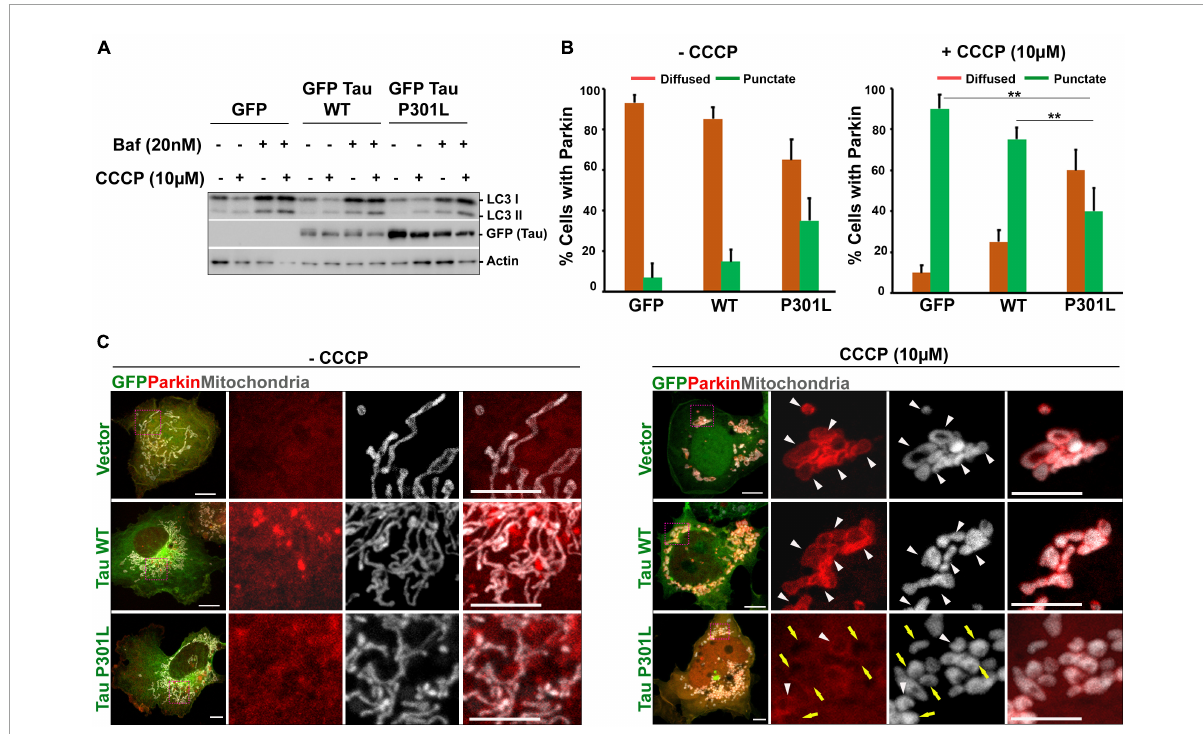
FIGURE2 P301L inhibits parkin translocation to mitochondria in COS7 Cells: (A) Representative immunoblot to show that autophagy flux is not altered in cells expressing either wild-type or P301L tau. Cells were treated with CCCP (10 µ M) to induce mitophagy. Bafilomycin (20 nM) was used to inhibit the fusion of autophagosomes with lysosomes. (B) Quantitative analysis representing the number of cells showing mitochondrial parkin (punctate) and cytosolic parkin (diffused) with and without CCCP treatment. Number of cells taken for quantification from three independent experiments (GFP: n = 29; GFP Tau WT: n = 30; GFP Tau P301L: n = 35). Multiple images were acquired from the random fields to measure the parkin translocation. (C) Representative confocal images showing the redistribution of parkin upon mitochondrial damage by CCCP. Cells co-expressing mCherry Parkin along with GFP, GFP Tau WT, and GFP Tau P301L were treated with 10 µ M CCCP for 4 h. MitoBFP was used to visualize mitochondria. White triangle indicate the mitochondria with parkin, while yellow arrow indicates the defective parkin recruitment to mitochondria. Scale bar = 10 µ m. Error bars represent SEM. ** P <